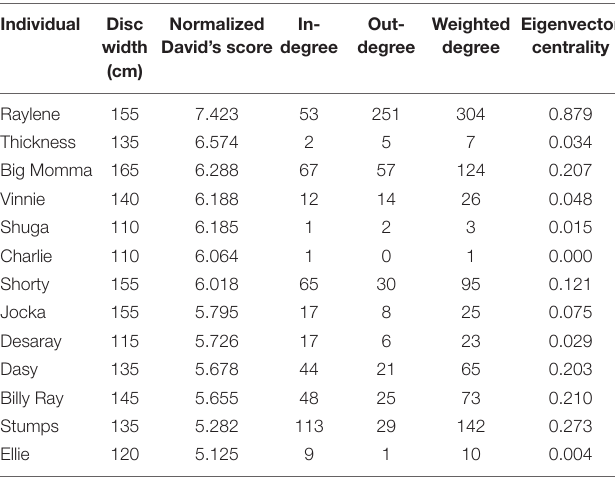
TABLE 1 | Summary of individual size, dominance (Normalized David’s score) and egocentric metrics calculated for the social network. Individual Disc Normalized In- Out- Weighted Eigenvector width David’s score degree degree degree